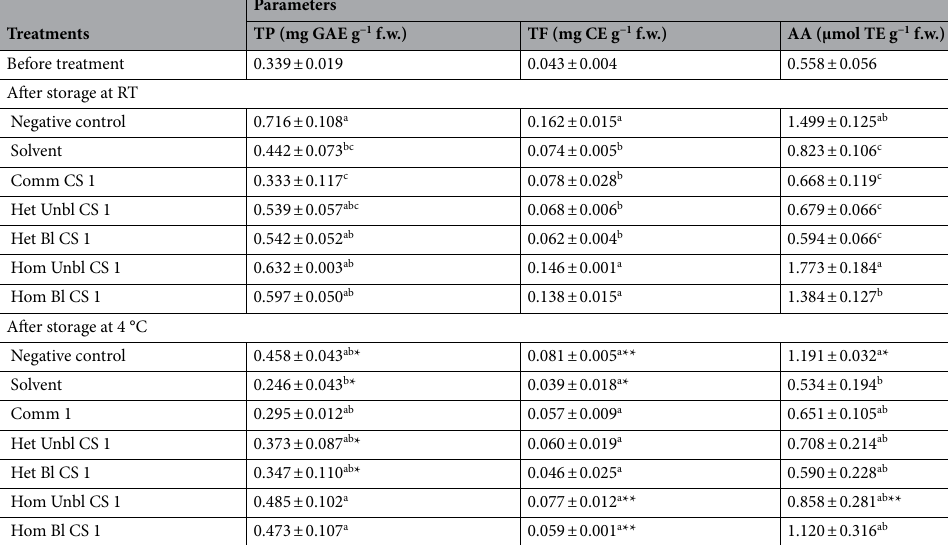
Table 5. Results of evaluation of total phenols (TP), total flavonoids (TF) and antioxidant activity (AA) on whole tomatoes, coated by spraying, after 30 days of storage at room temperature (RT) and 4 °C. Treatments: untreated fruits (negative control), solvent only, coating with heterogeneous unbleached (Het Unbl CS), heterogeneous bleached (Het Bl CS), homogeneous unbleached (Hom Unbl CS), homogeneous bleached (Hom Bl CS) and commercial (Comm CS) chitosan. GAE, gallic acid equivalents. CE, catechin equivalents. TE, Trolox equivalents. Means followed by different letters in the column are significantly different by Mann– Whitney U test (p < 0.05). Each trial contained three triplicates of whole tomatoes per each treatment. Asterisks indicate significant differences (*p < 0.05; **p < 0.01) between the two storage temperatures within the same treatment, according to Mann–Whitney U